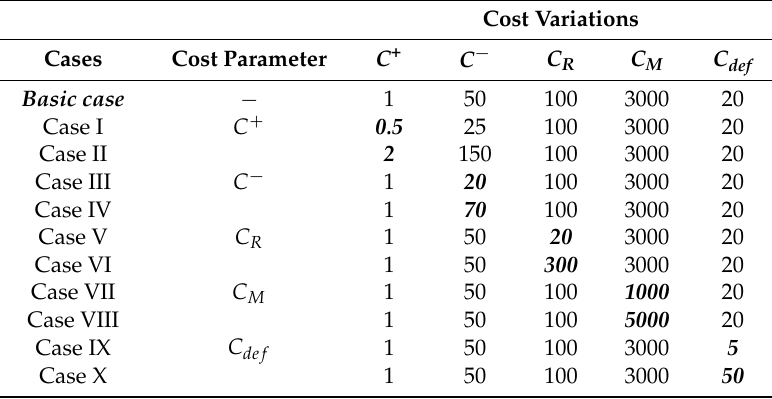
Table 6. Sensitivity analysis for different cost